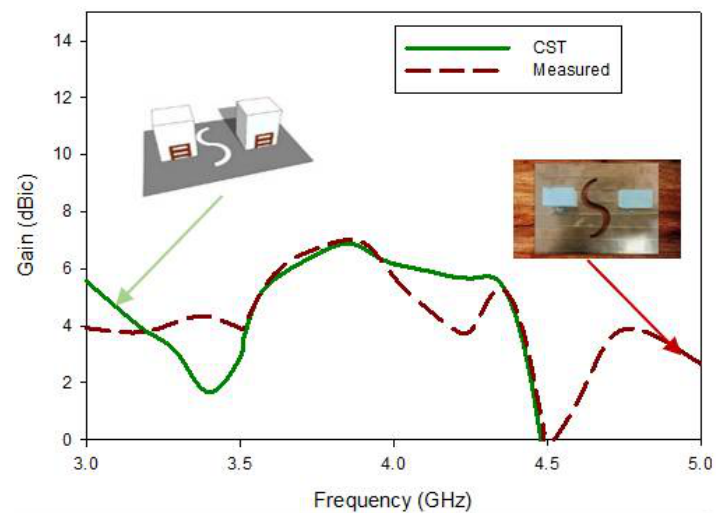
Figure 19. Comparison of the gain of the fabricated and simulated MIMO antenna. Similarly, the behavior of the desired MIMO RDRA antenna demonstrates through ECC and DG. Information regarding the coupling at the ports illustrates only through isolation parameters ( S 12 / S 21